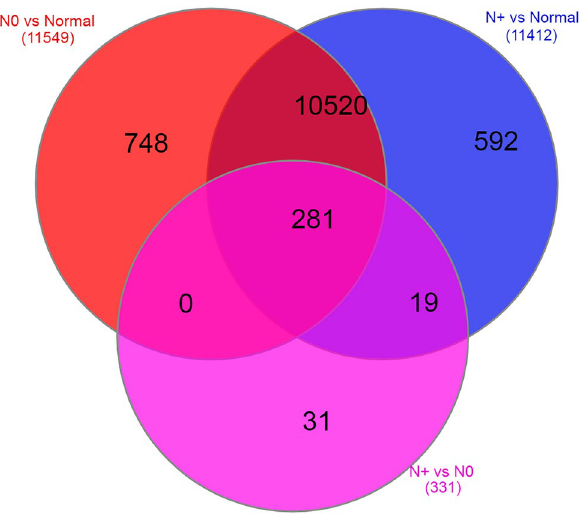
Figure 2. Identification of dedicated and overlapping up-regulated DEGs related to N + and N0 conditions.